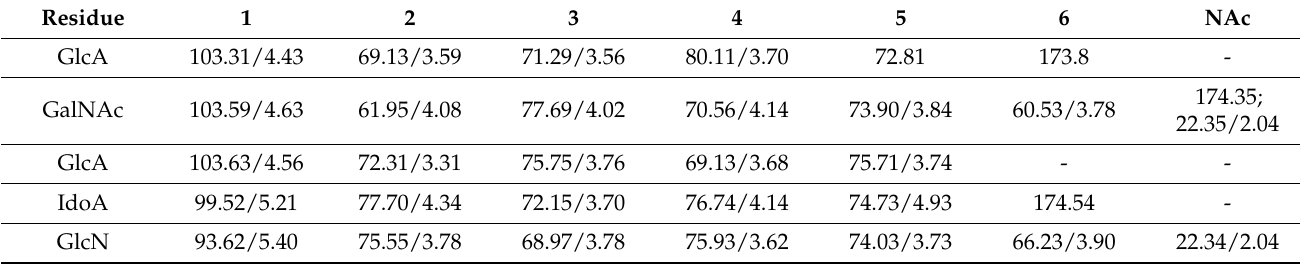
Figure 4. 1 H/ 13 C HSQC spectrum of F1 ( A ), F2 ( B ). Table 3. 1 H and 13 C NMR chemical shifts of F1 and